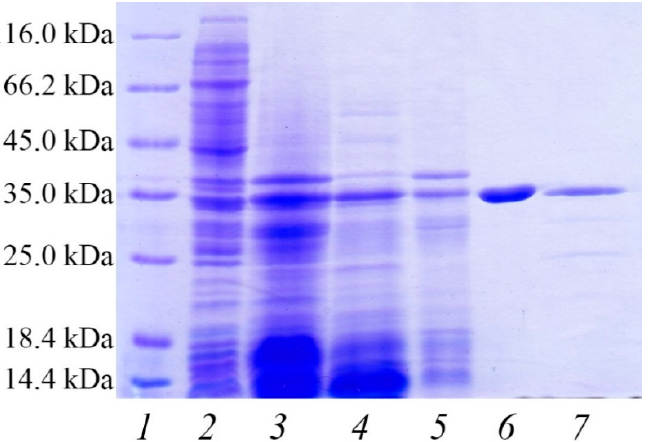
Figure 4. SDS-PAGE analysis of expression, folding and purification of alkaline protease from A. ochraceus VKM-F4104D (PAPC): 1—protein molecular weight marker, 2—uninduced E. coli BL21 (DE3), 3—induced E. coli BL21 (DE3), 4—supernatant of centrifugation after sonication (soluble frac- tion), 5—pellet of centrifugation after sonication (insoluble fraction), 6—soluble fraction of PAPC